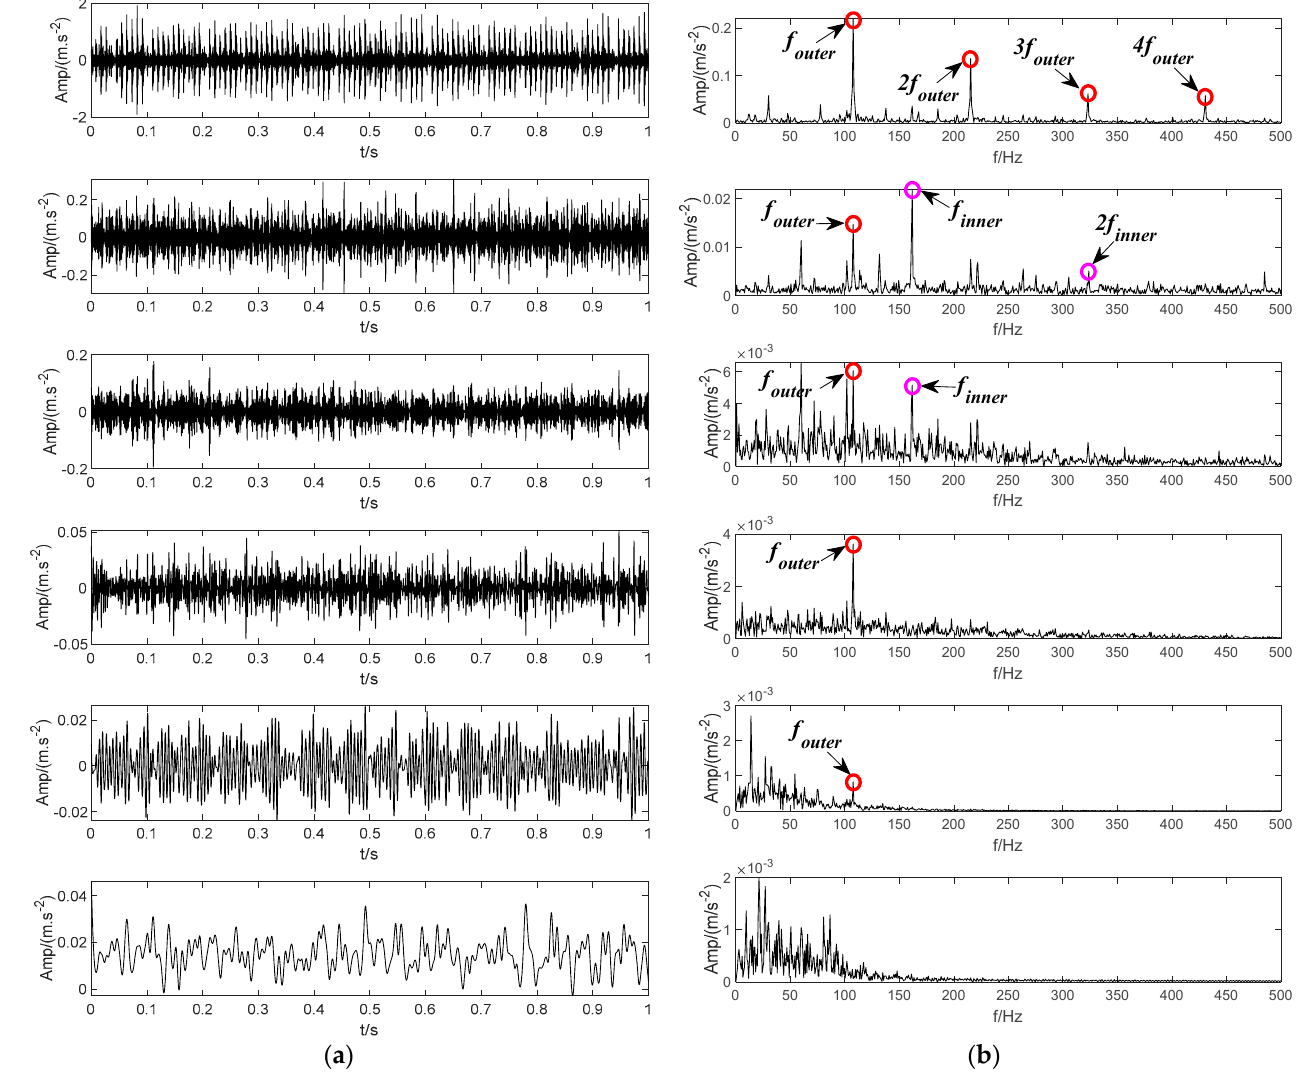
Figure 18. Decomposition result of CEEMDAN method. ( a ) The IMF components. ( b ) Envelope spectrums.